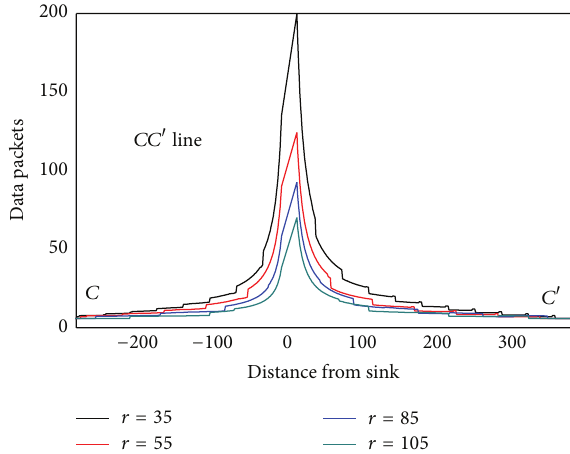
Figure 6: Data load under different communication ranges.